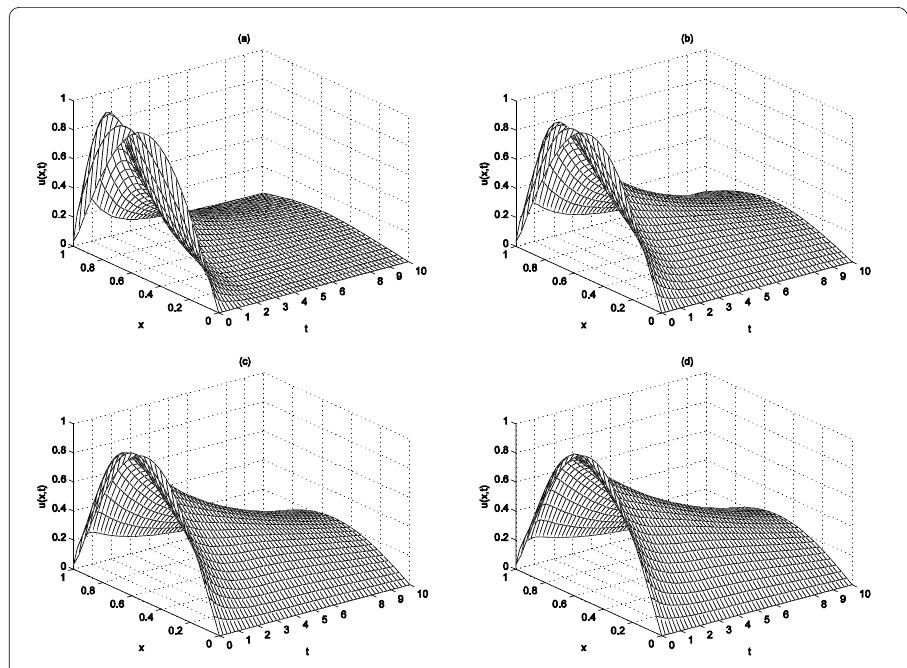
Figure 1 A 3-d landscape of the dynamics of the MGKdVB equation when using the first nonlinear control law; v = 0.01, μ = 0.001, γ 1 = 1, γ 2 = 0.0005 and u 0 ( x ) = sin( π x ); ( a ) α = 1; ( b ) α = 2; ( c ) α = 3; ( d ) α =